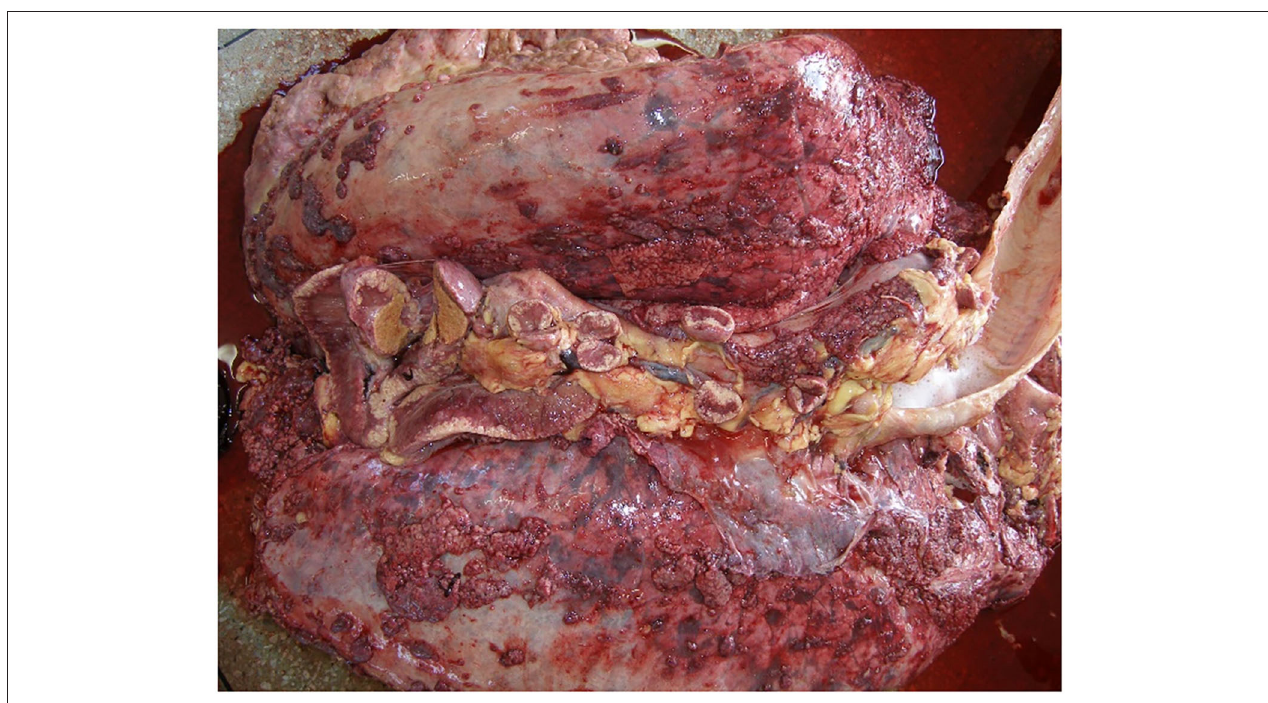
FIGURE 1 | Granulomatous lesions distributed in lung and mediastinal lymph nodes of bovines.